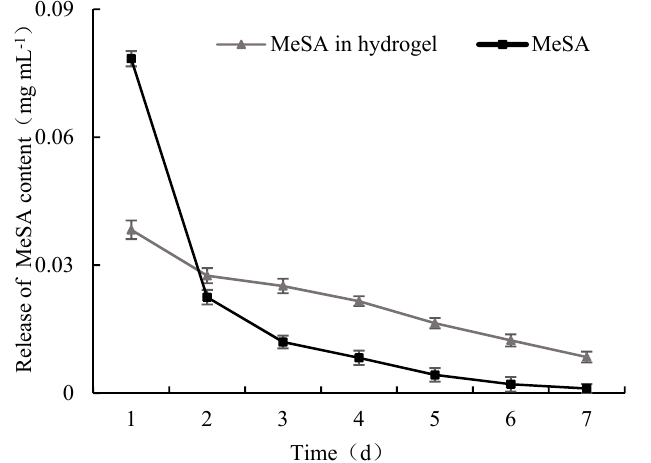
Figure 6. The release properties of MeSA in hydrogel. Each value represents mean ± standard deviation of three replicates.